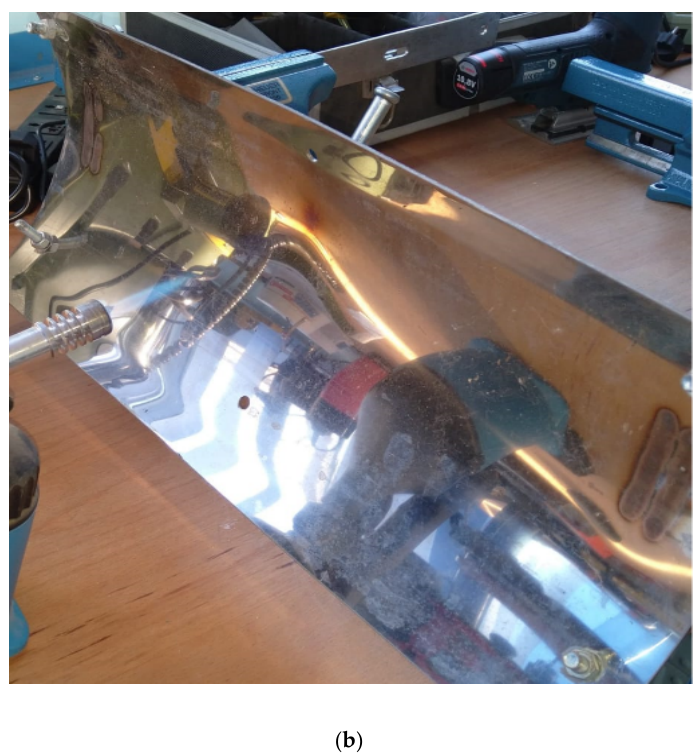
Figure 3. The single shield experiment. ( a ) the representation of the heat shield temperature mea- surement system. At the top of the figure is the Sonel KT-145 temperature measuring device. At the bottom the heat shield and the open flame lamp. ( b ) the material from which the shield is made has a high reflection index.